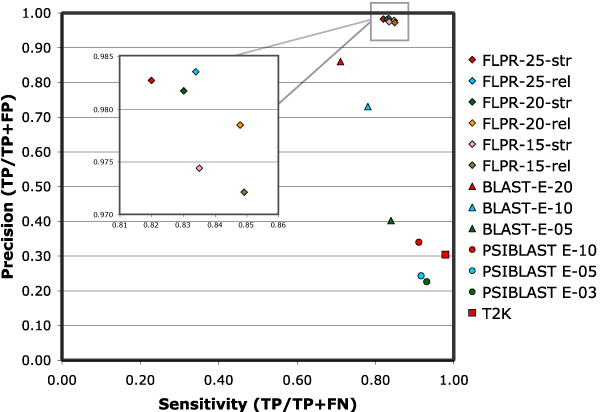
Comparison of performances of BLAST, PSIBLAST, T2K and FlowerPower in identifying global homologs. The X-axis refers to the average sensitivity (or recall) of each method across the dataset and the Y-axis refers to the average precision (or selectivity). Sensitivity is the fraction of the target homolog set identified by a method (i.e., TP/TP+FN). Precision is the fraction of the set selected by a method that belongs to the same domain architecture class (i.e., TP/TP+FP). Results of FlowerPower at varying parameterizations are presented including percent identity cutoffs for sequence selection (25%, 20% and 15%) and stringent ("str") and relaxed ("rel") query and hit coverage cutoffs, based on sequence length. The BLAST parameters refer to e-value cutoffs of 10-20, 10-10 and 10-5. For PSI-BLAST the e-value cut-off used were 10-10, 10-5 and 10-3, using three iterations. T2K was run using default parameters. The inset displays FlowerPower results using different parameterizations.